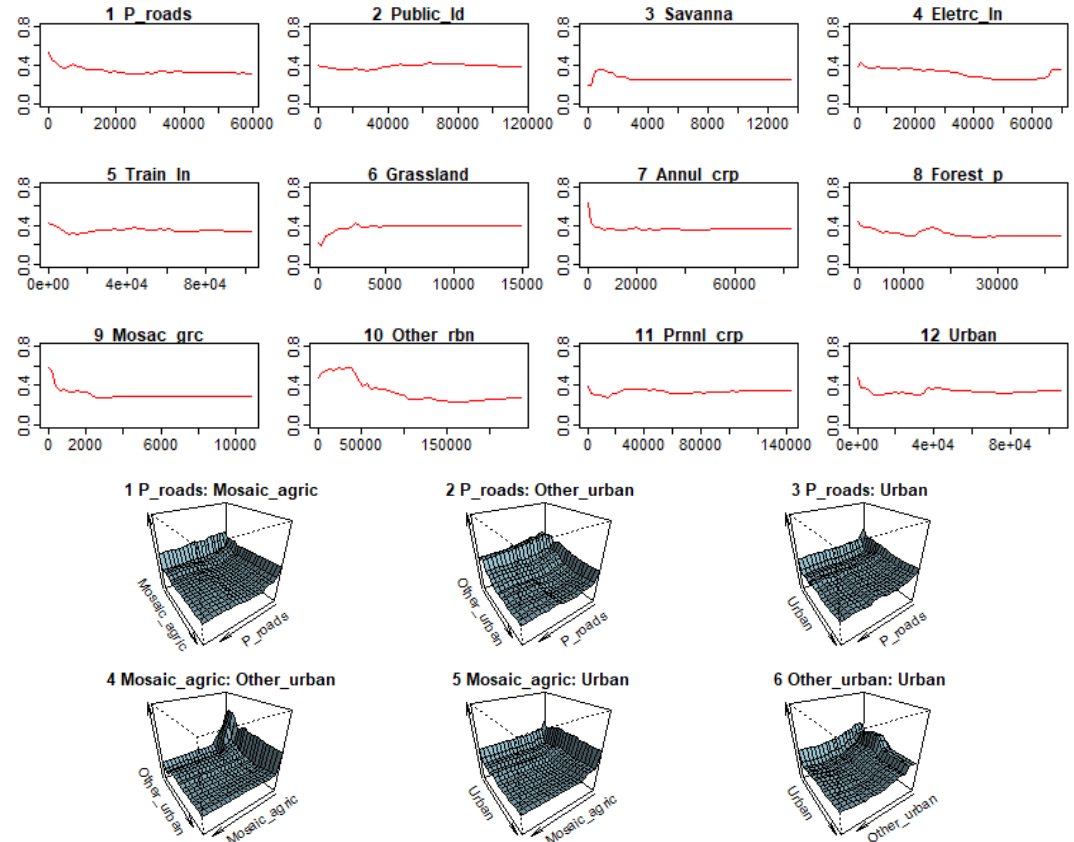
Figure 10. Response curves (top) and variable interactions (bottom) for predictive variables of RF.